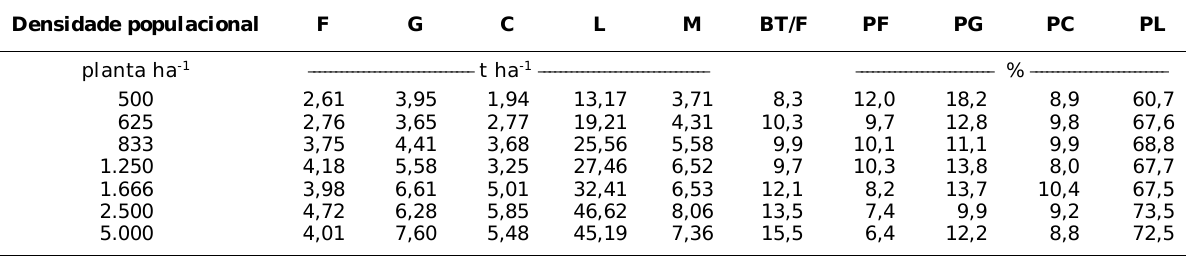
F = folhas; G = galhos; C = casca; L = lenho; M = manta orgânica; BT/F relação entre matéria seca da biomassa total da parte aérea e matéria seca de folhas; PF = contribuição percentual de folhas; PG de galhos; PC de casca e PL de lenho na composição da biomassa total da parte